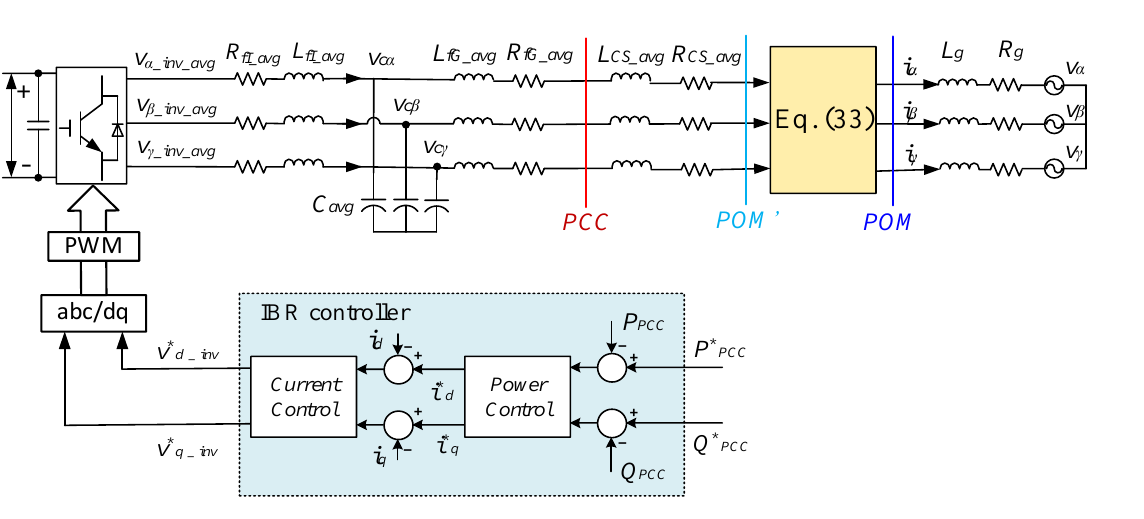
Figure 9. Aggregated IBR plant model for Case 3.